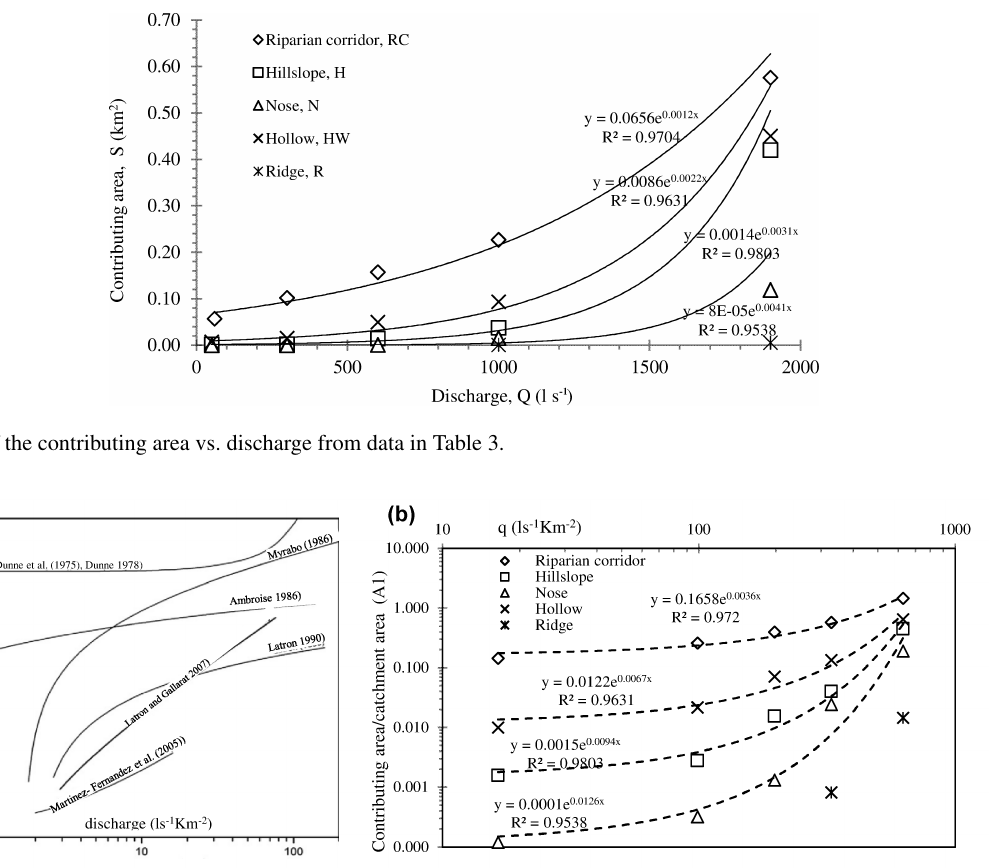
Figure 15. (a) Relationship between the total extent of contributing saturated areas and the baseflow discharge in several small (less than 10km 2 ) catchments (modified from Latron and Gallarat, 2007); (b) relationship between the contributing areas and the specific discharge for each hydro-geomorphotype of the Ciciriello